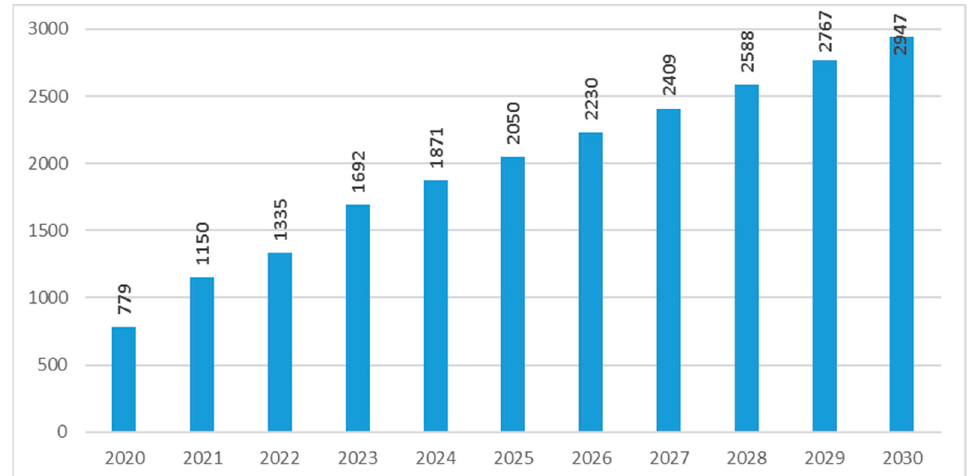
Figure 4. The projected installed capacities of solar installations in Ukraine in households and energy cooperatives, MW [24]. Table 1. Regional multipliers for Ukraine [30].